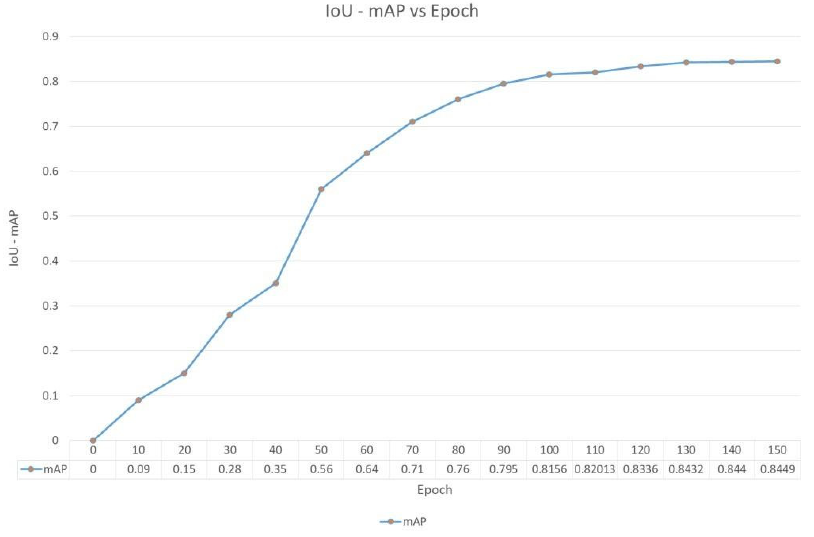
Figure 12. Comparison of IoU mAP vs. Epoch.